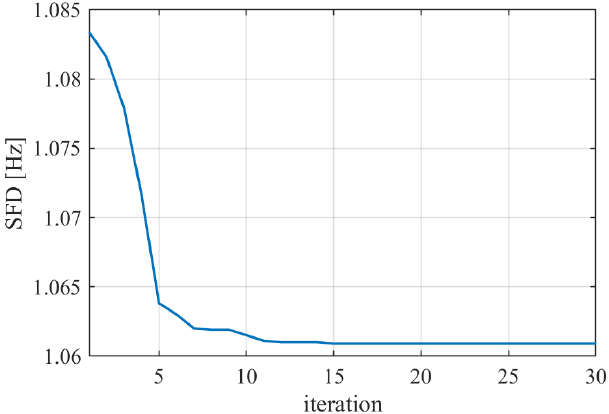
Figure 8. PSO convergence behavior.